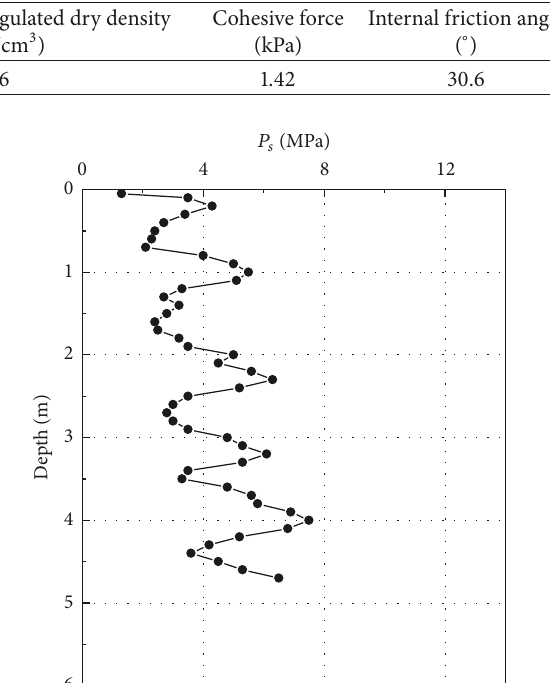
Table 3: Physical and mechanical parameters of sand with regulated dry density.